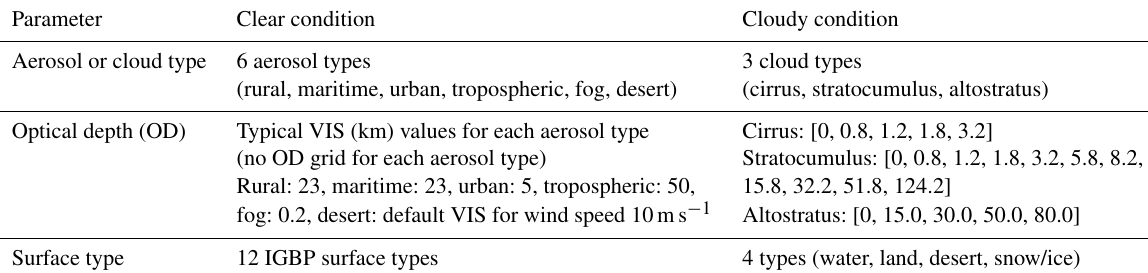
Table 3. The various classes for which NTB coefficients are generated. Parameter Clear condition Cloudy condition Aerosol or cloud type 6 aerosol types 3 cloud types (rural, maritime, urban, tropospheric, fog, desert) Optical depth